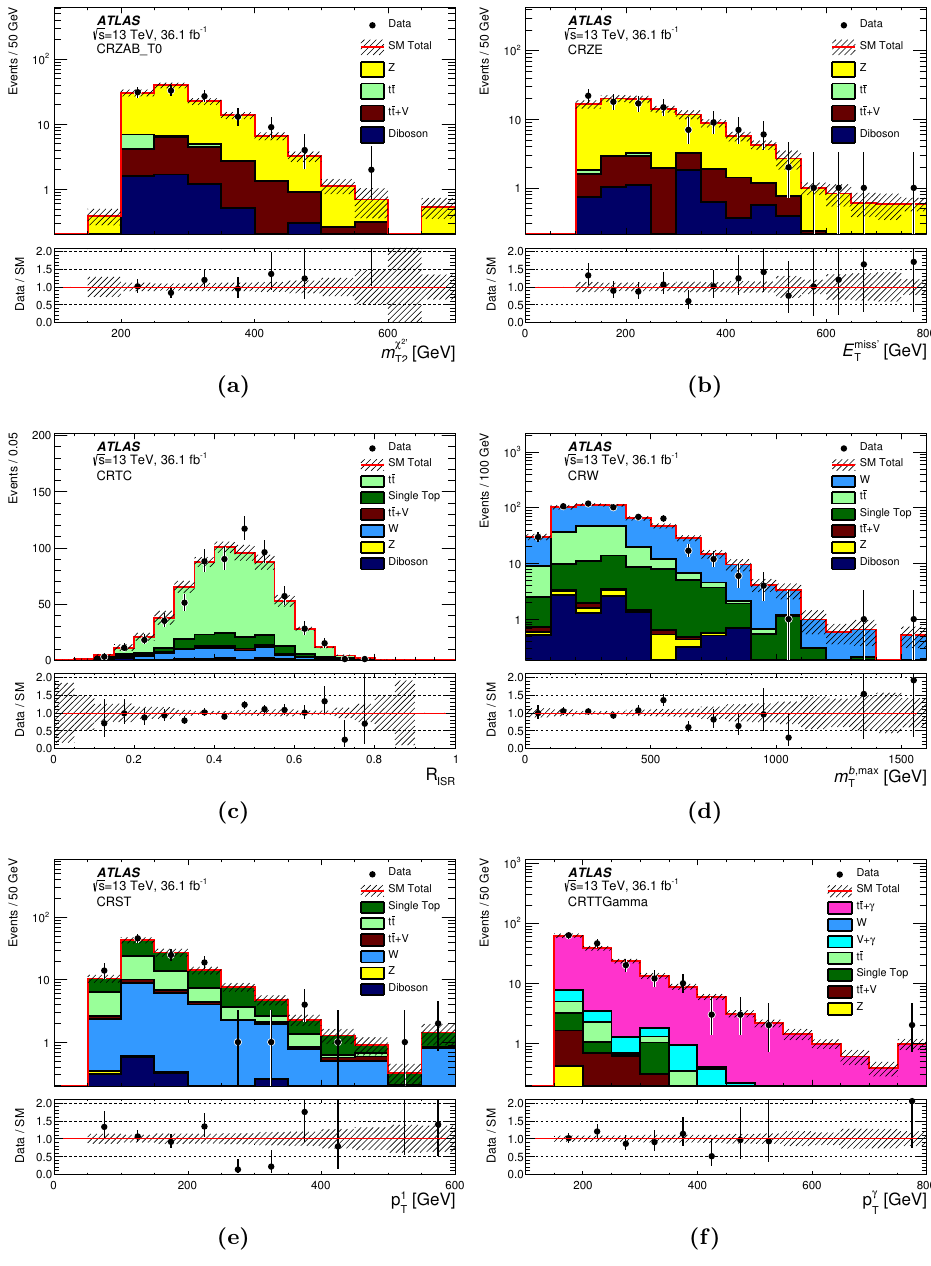
0 Figure 4. Distributions of (a) m (cid:31) 2 in CRZAB-T0, (b) E miss 0 in CRZE, (c) R ISR in CRTC, T T2 (d) m b; max in CRW, (e) the transverse momentum of the second-leading- p T jet in CRST, and T (f) the photon p T in CRTTGamma. The stacked histograms show the SM prediction, normalized using scale factors derived from the simultaneous (cid:12)t to all backgrounds. The \Data/SM" plots show the ratio of data events to the total SM prediction. The hatched uncertainty band around the SM prediction and in the ratio plot illustrates the combination of MC statistical and detector-related systematic uncertainties. The rightmost bin includes over(cid:13)ow